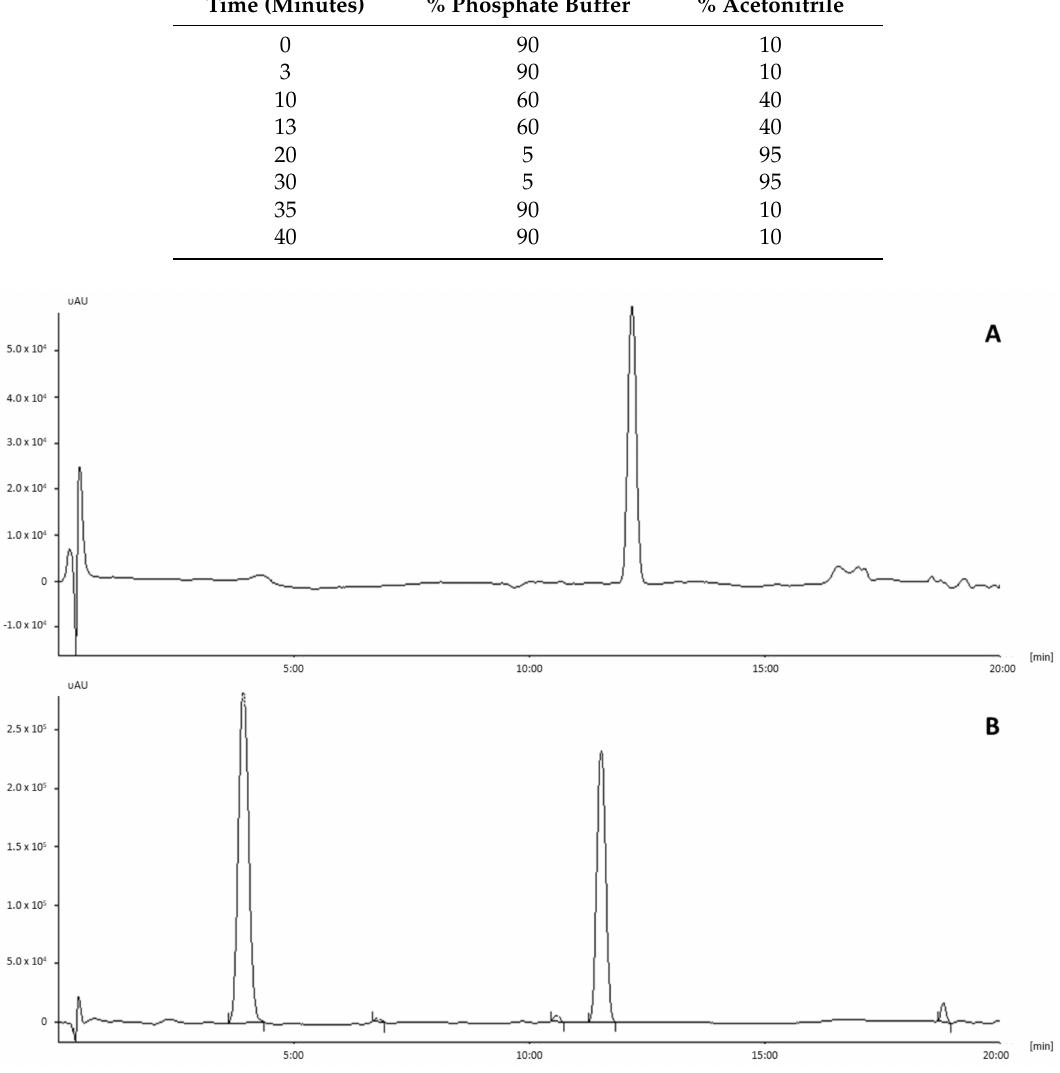
Table A2. HPLC analysis for 1b . Hypersil ODS RP18 column (3 µ m, 4.6 × 100 mm). Flow rate: 2 mL/min.